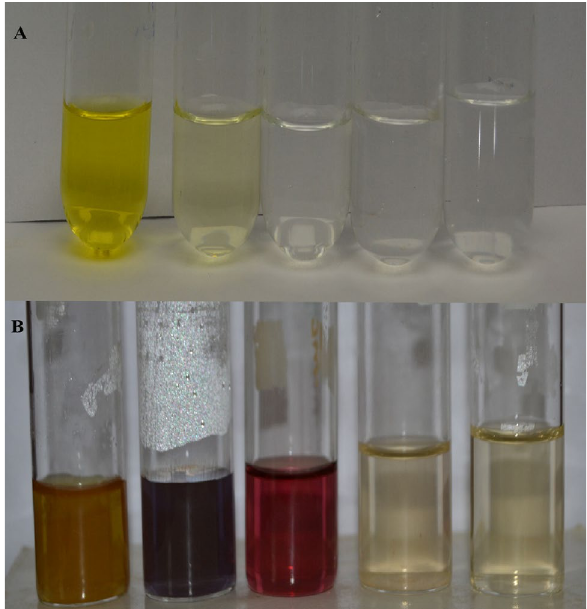
Figure 7. ( A ) Gold solution at various concentration, ( B ) gold nanoparticle colloid solutions.